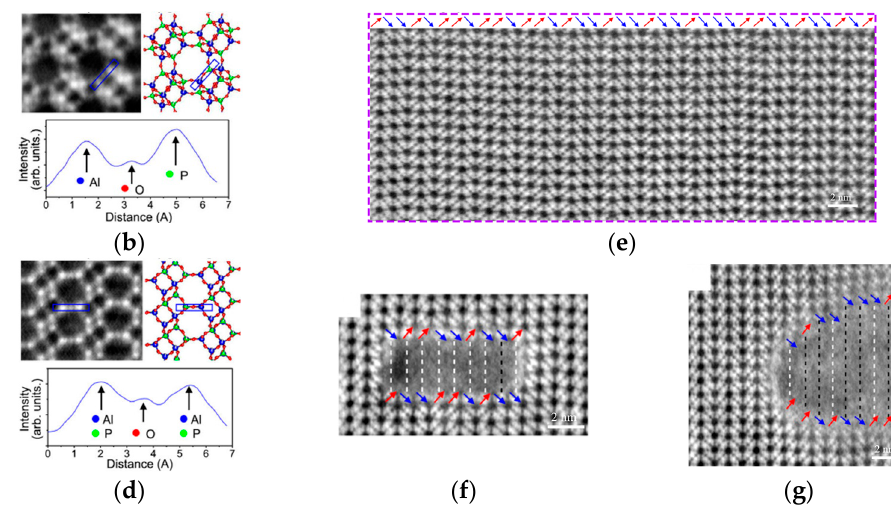
Figure 14. ( a – d ) Magnified iDPC-STEM images with red box and intensity profiles (for red box) of SAPO-18 ( a , c ) and SAPO-34 ( b , d )with blue box; ( e ) iDPC-STEM image of highly mixed SAPO-34 and SAPO-18 lattices inside; ( f , g ) iDPC-STEM images show the stacking sequences. Reprinted/adapted with permission from Ref. [109]. Copyright 2021, Applied Physics Letters.